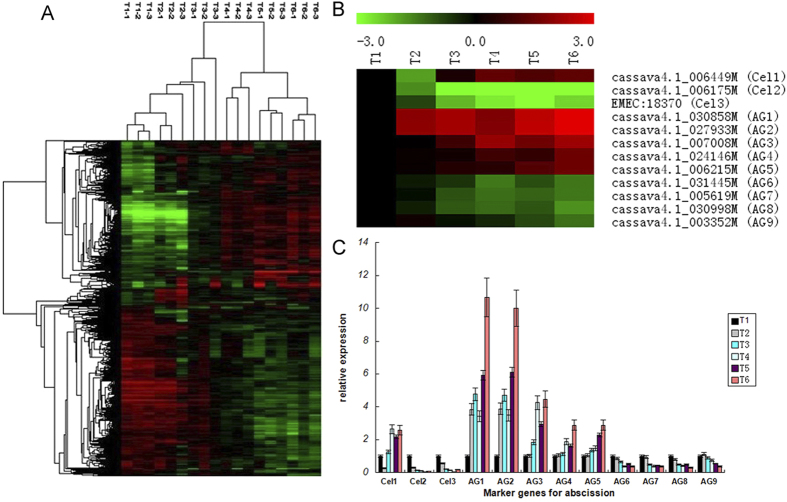
Time series cassava leaf pulvinus AZ transcriptome over six time points during leaf abscission.Hierarchical clustering analyses of differentially expressed genes. (A) The 10001 differentially expressed genes were clustered using hierarchical clustering. The signals are shown in a red-green color scale, where red represents higher expression and green represents lower expression. The numbers represent the time point during water-deficit stress and each sample was repeated three times; (B) The microarray expression ratios (P < 0.001) for marker genes involved in cell-wall hydrolysis during abscission, cellulase (Cel) or polygalacturonase (AG); (C) QRT-PCR analysis performed the expression patterns of cellulase (Cel) and polygalacturonase (AG). Relative expression levels were determined after normalizing all data to that of T1, which was set to 1.0. Error bars represent SD for three independent experiments.